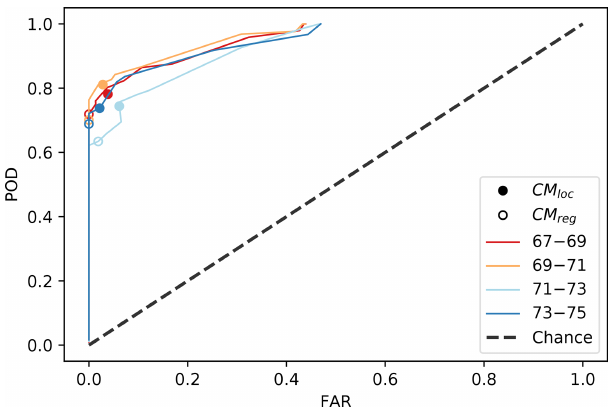
Figure 8. Relationship of POD and FAR for local and regional cloud masks (CM loc and CM reg ; filled and transparent circles) and for a range of different HRV threshold values and four solar zenith angle (SZA) bins (coloured lines). HRV threshold values increase from the top to the bottom of the plot, i.e. from HRV minimum to HRV maximum per SZA. The pseudo-ROC curve shows the best performance of the HRV threshold values used for cloud masking in the upper-left corner, while accuracy decreases towards the dashed diagonal